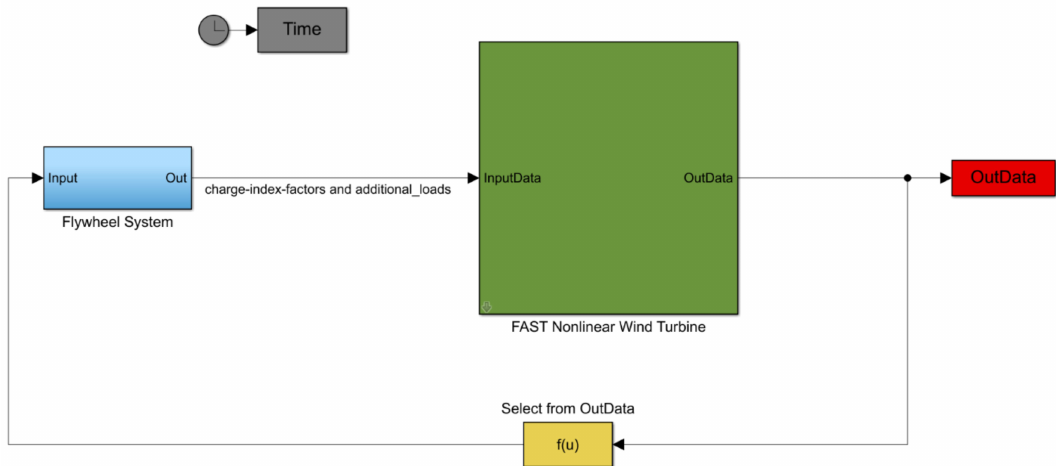
Figure 4. Flywheel_System.mdl model in OpenFAST Simulink